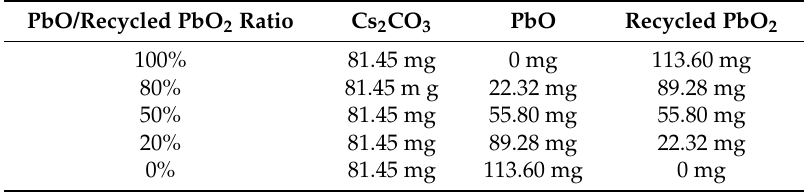
Figure 1. Technical procedure for CsPbBr 3 -QD preparation using recovered waste lead from discarded lead–acid batteries. ( a ) Discarded lead–acid battery, ( b ) Electrode inside battery, ( c ) Recycled electrodes (PbO 2 anode and Pb cathode), ( d ) Grinding PbO 2 , ( e ) Collected PbO 2 powder, and ( f ) CsPbBr 3 -QDs with different ratios under UV-365 nm laser excitation (left to right: PbO/recycled PbO 2 ratio = 100%, 80%, 5%, 20%, and 0%). Table 1. The CsPbBr 3 -QD deployment ratio in this work.